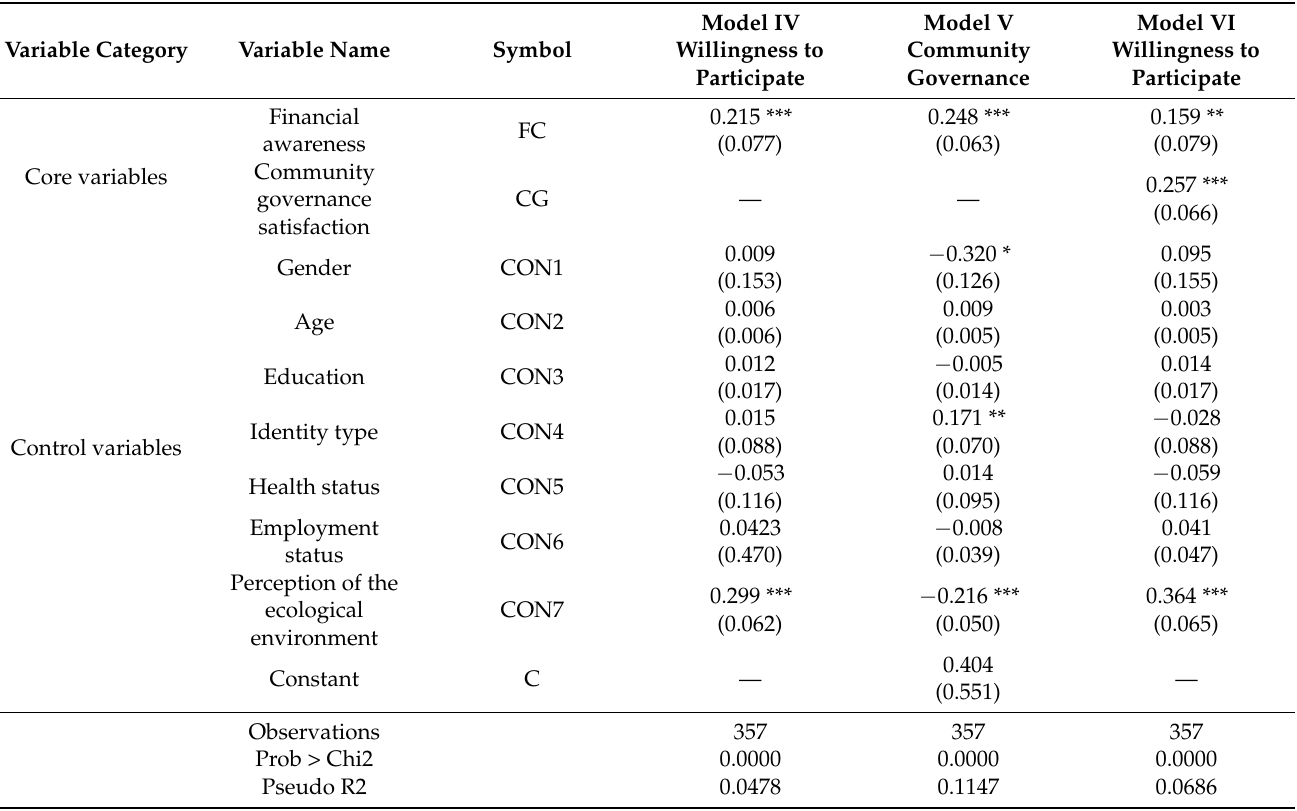
Table 5. Robustness test I.